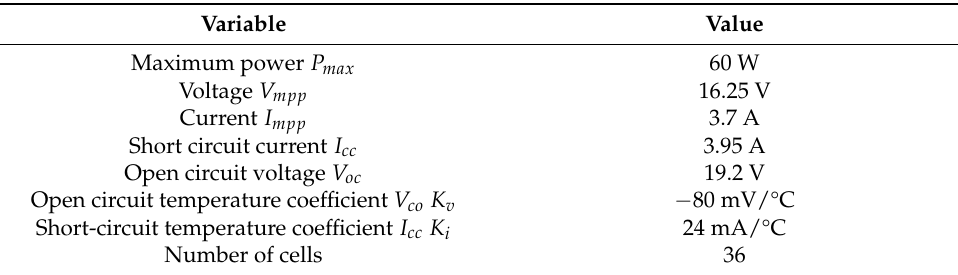
Figure 1. Topology of the studied system. Table 1. MSC-60 solar PV module